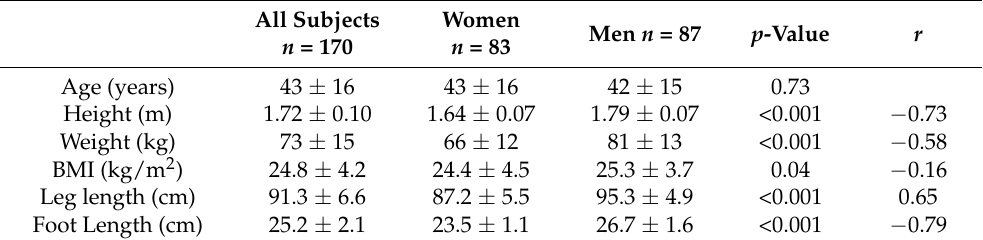
Table 1. Mean ± SD of subject characteristics. p -values are the results of a Mann—Whitney U Test by sex and effect size r is computed using the Rosenthal equation [28]: r = z / √𝑁 (with a small effect when r ≈ 0.1, a medium effect when r ≈ 0.3 and a large effect when r ≳ 0